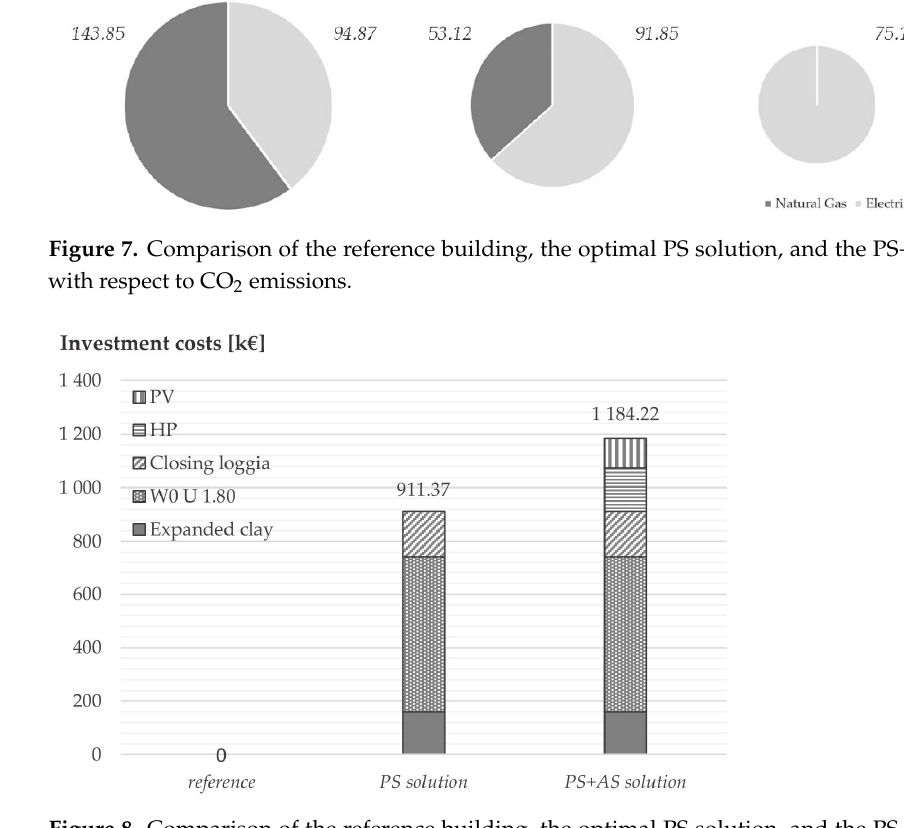
Figure 7. Comparison of the reference building, the optimal PS solution, and the PS+AS solution with respect to CO 2 emissions.